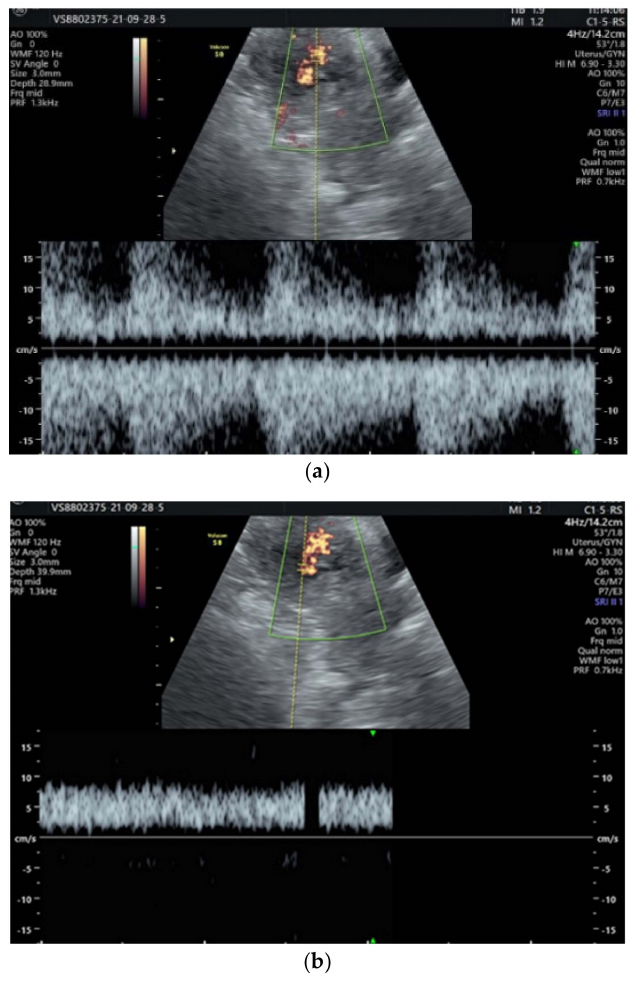
Figure 3. Pulsatile Doppler ultrasound: ( a ) Arterial flow; ( b ) venous